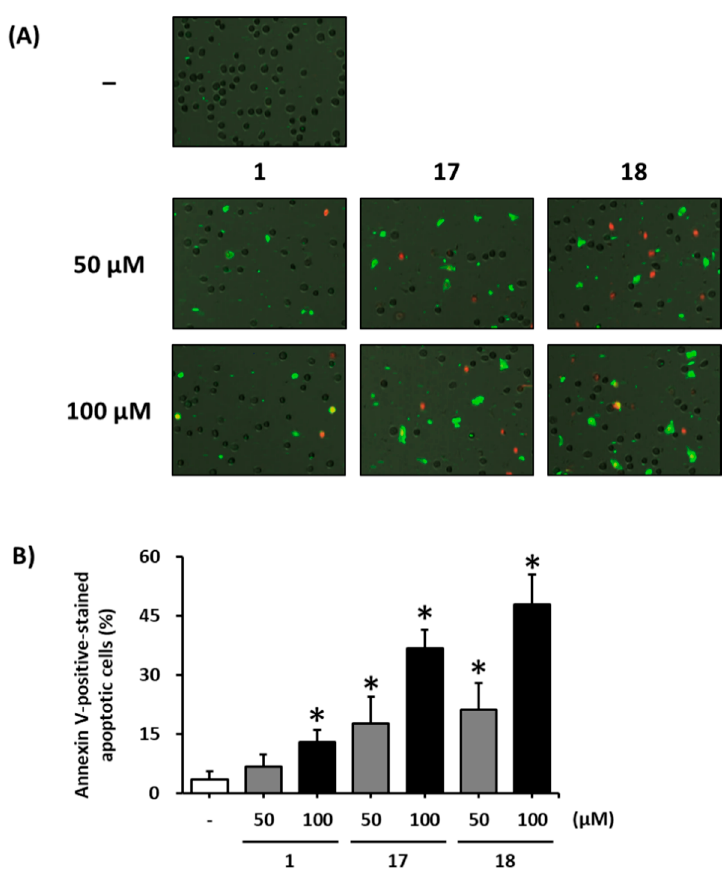
Figure 4. Apoptotic effects of gallic acid ( 1 ), decursin ( 17 ), and decursinol angelate ( 18 ) on MCF-7 cells treated to indicated concentrations for 24 h. The apoptotic cell ratio was analyzed by using Alexa Fluor 488 annexin-V conjugate staining. ( A ) Representative images of detection for apoptotic cells. ( B ) The ratio of apoptotic cells stained positive for annexin V. The data are presented as the mean ± S.D. and were analyzed using a one-way analysis of variance (ANOVA) and a Dunnett’s multiple comparisons post hoc analysis. * p < 0.05 versus untreated cells.